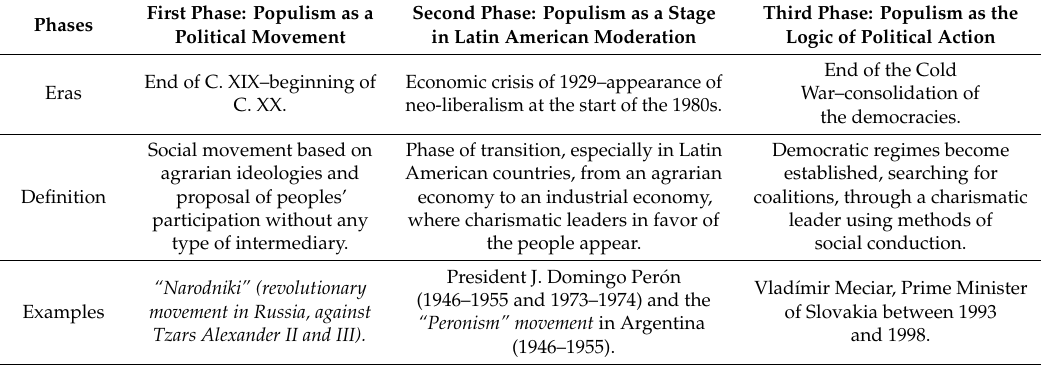
Table 1. Periods of